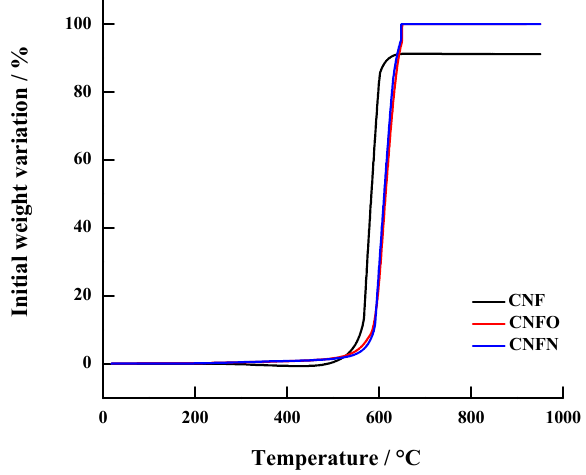
Figure 3. Thermogravimetric analysis (TGA) of the carbon nanofibers used as support of the Pd ‐ Ni catalysts.